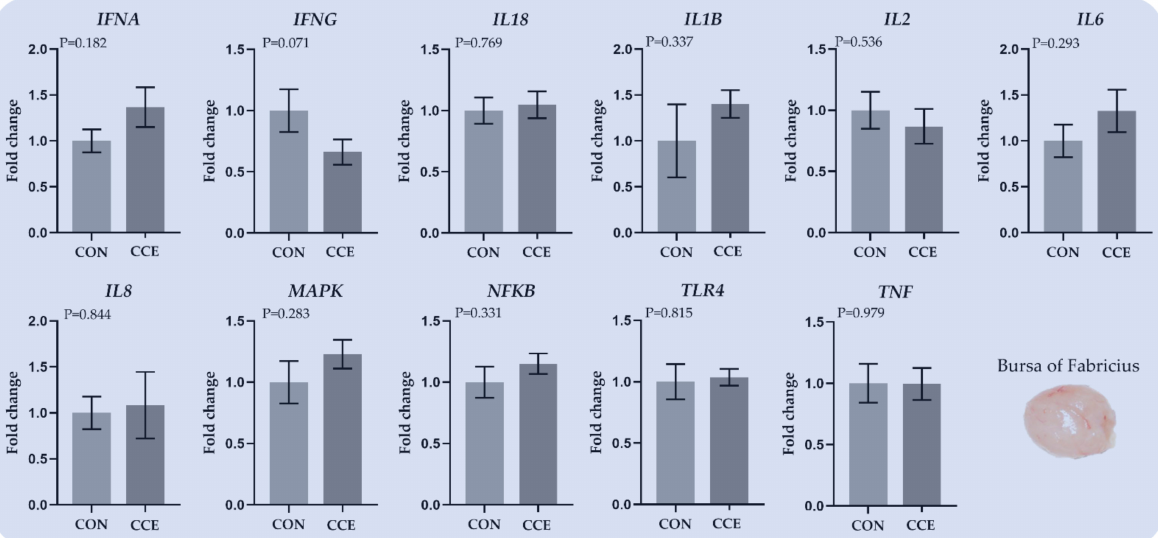
Figure 8. The mean and standard error of means (SEM) of relative transcript levels as fold changes of several genes involved in the immune system in the bursa of Fabricius of broilers fed the two experimental diets (Control; CON and carotenoid extract from Citrus reticulata included in soluble starch; CCE) at 42 days. INFA: Translation initiation factor IF-1, INFG: Interferon-gamma, IL18: